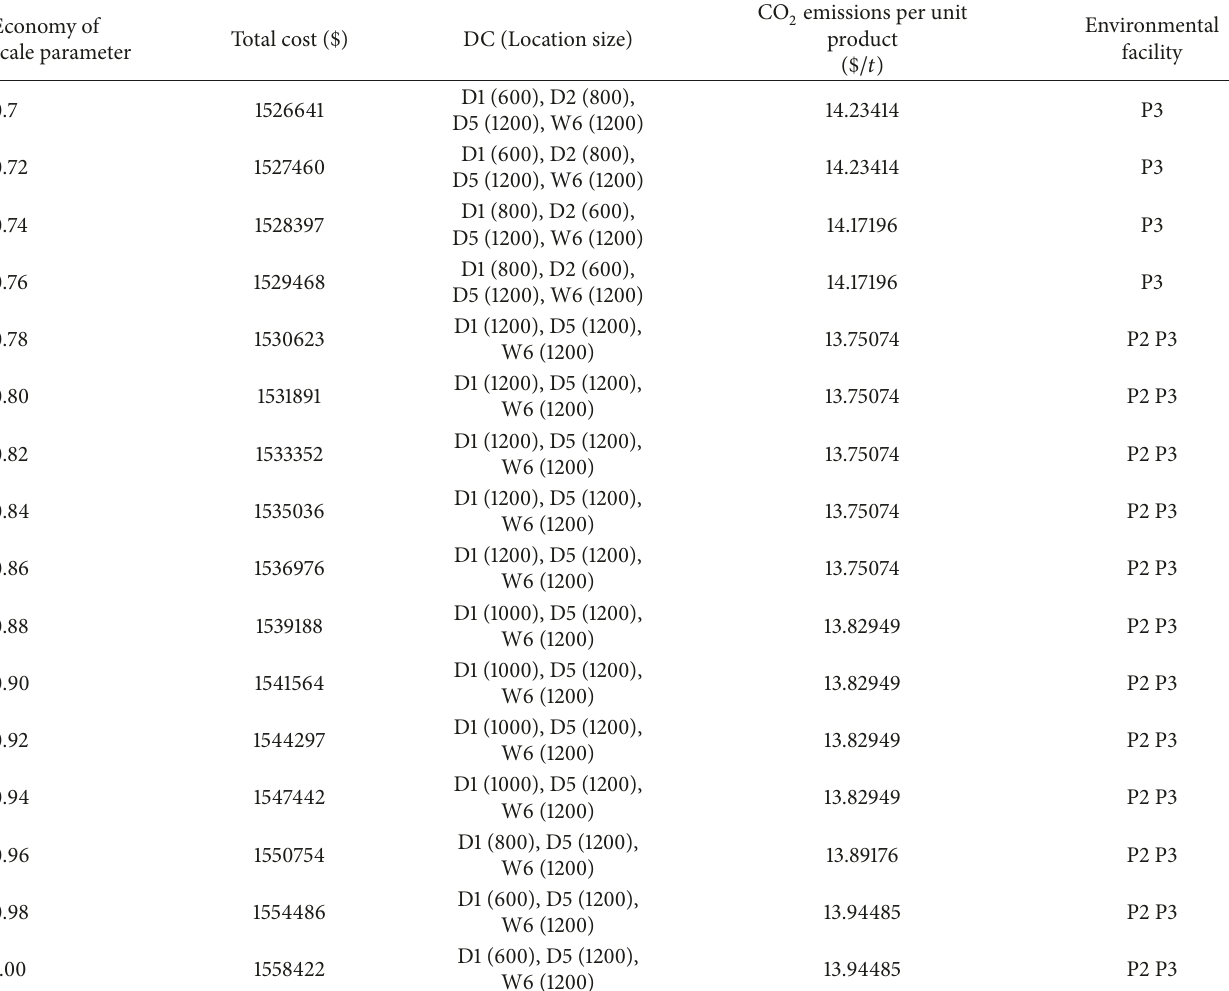
Table 11: Comparison based on different economies of scale